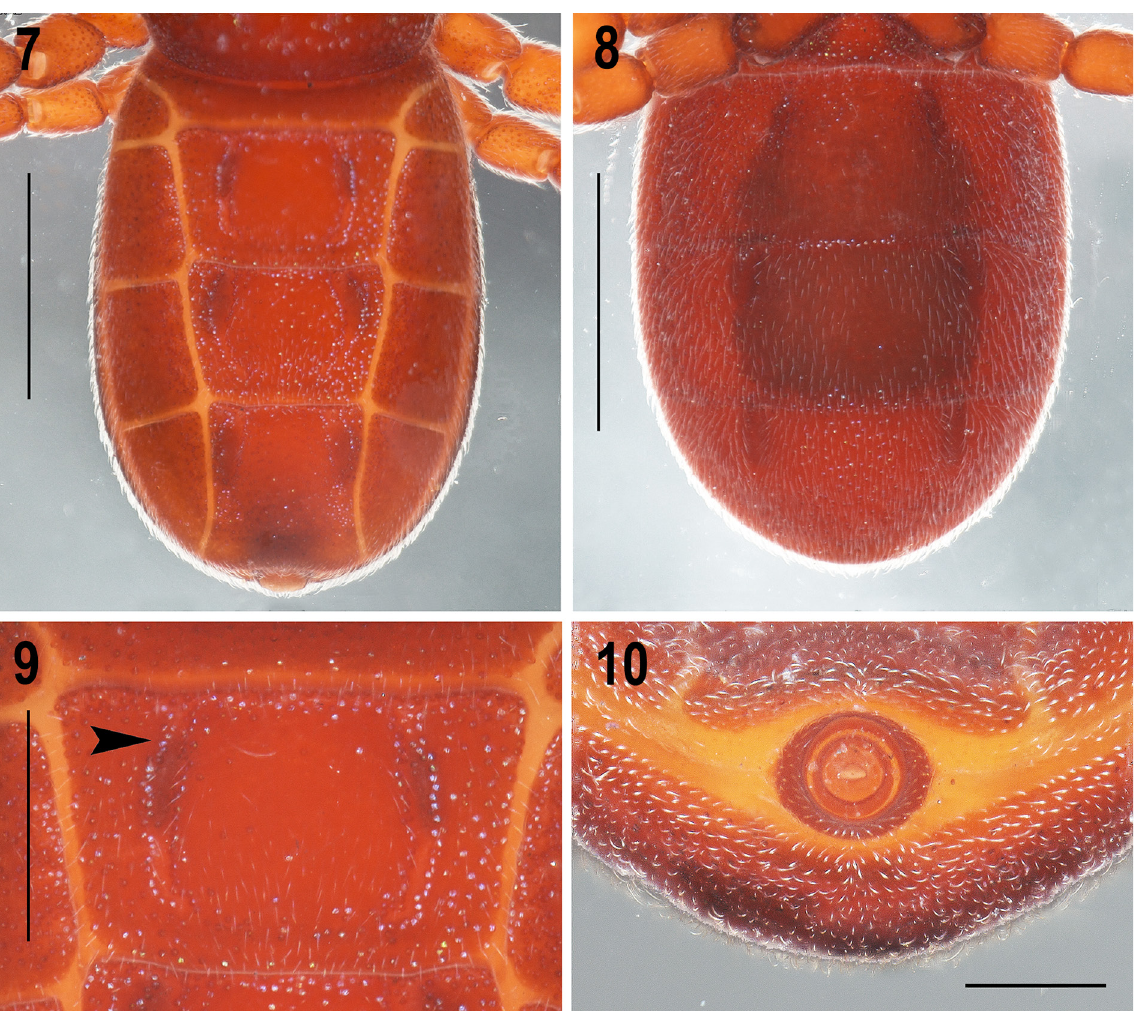
Figs 7–10. Pseudocellus giribeti sp. nov. Holotype, ♂ (MCZ 80010). 7–8 . Opisthosoma, dorsal and ventral views. 9 . Tergite XI, median plate (arrow indicates the lateral depression). 10 . Pygidium, posterior view. Scale bars: 7–8 = 1 mm; 9 = 0.5 mm; 10 = 0.2